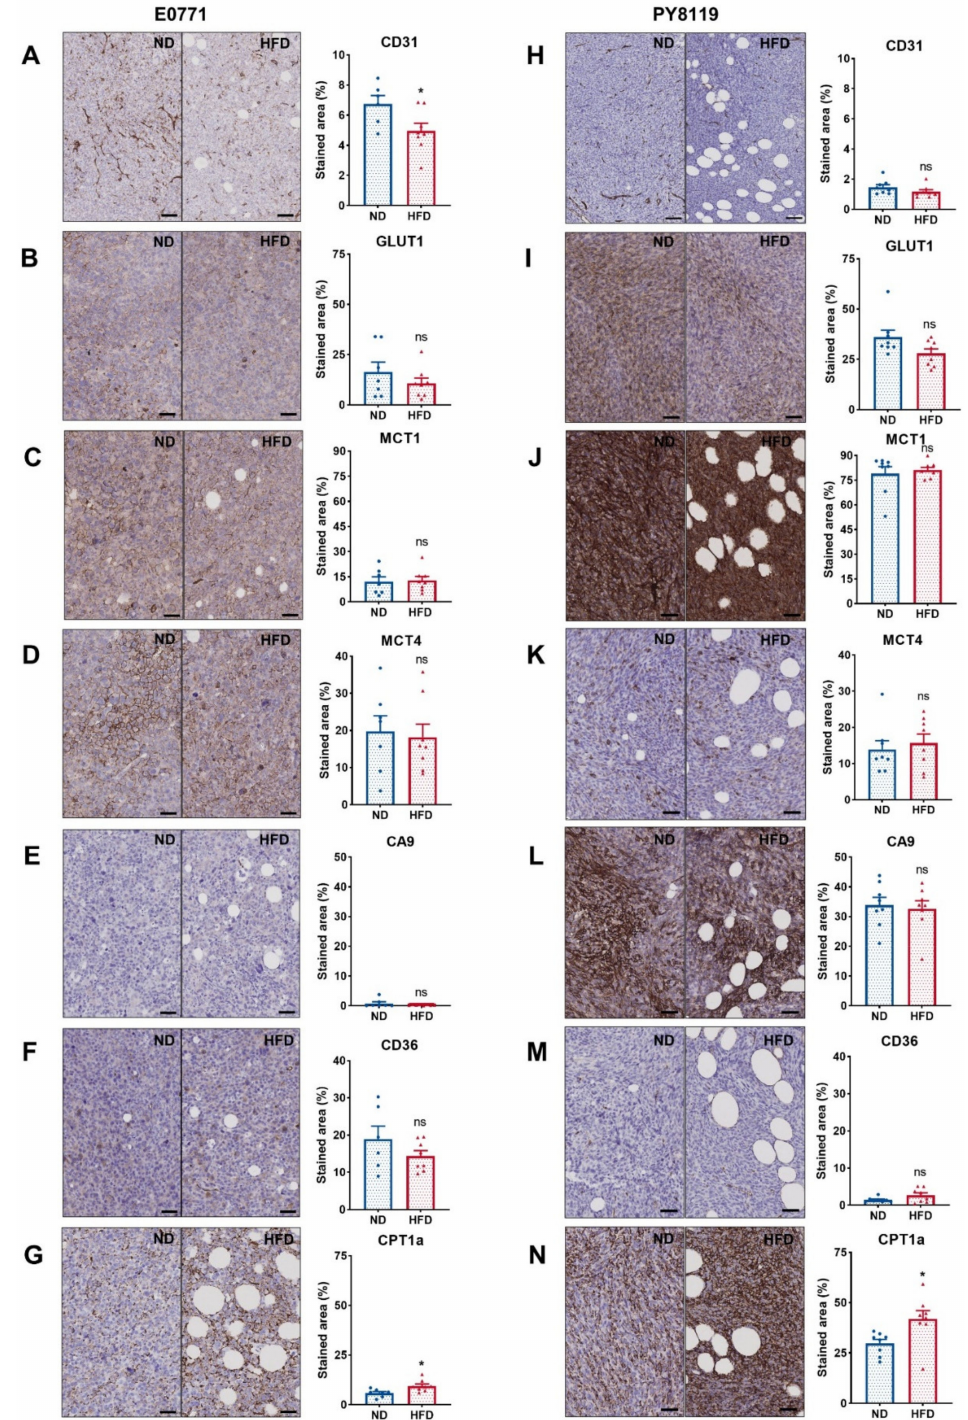
Figure 5. The expression of major metabolite transporters does not differ, except for CPT1a in breast tumors of obese and lean mice. ( A – G ): E0771 cell line; sample size: n = 7 for ND except ( A ) (lost sample), ( F ) (Grubb’s outlier) n = 6 and n = 8 for HFD. ( H – N ): PY8119 cell line; sample size: n = 8 for ND and n = 8 for HFD. ( A , H ) IHC staining for CD31 expression, scale bar = 100 µ m. ( B , I ) IHC staining for GLUT1. ( C , J ) IHC staining for MCT1. ( D , K ) IHC staining for MCT4. ( E , L ) IHC staining for CA9. ( F , M ) IHC staining for CD36. ( G , N ) IHC staining for CPT1a. All scale bars except for CD31 = 50 µ m. Statistical analyses: unpaired t -test; ns p > 0.05; * p <